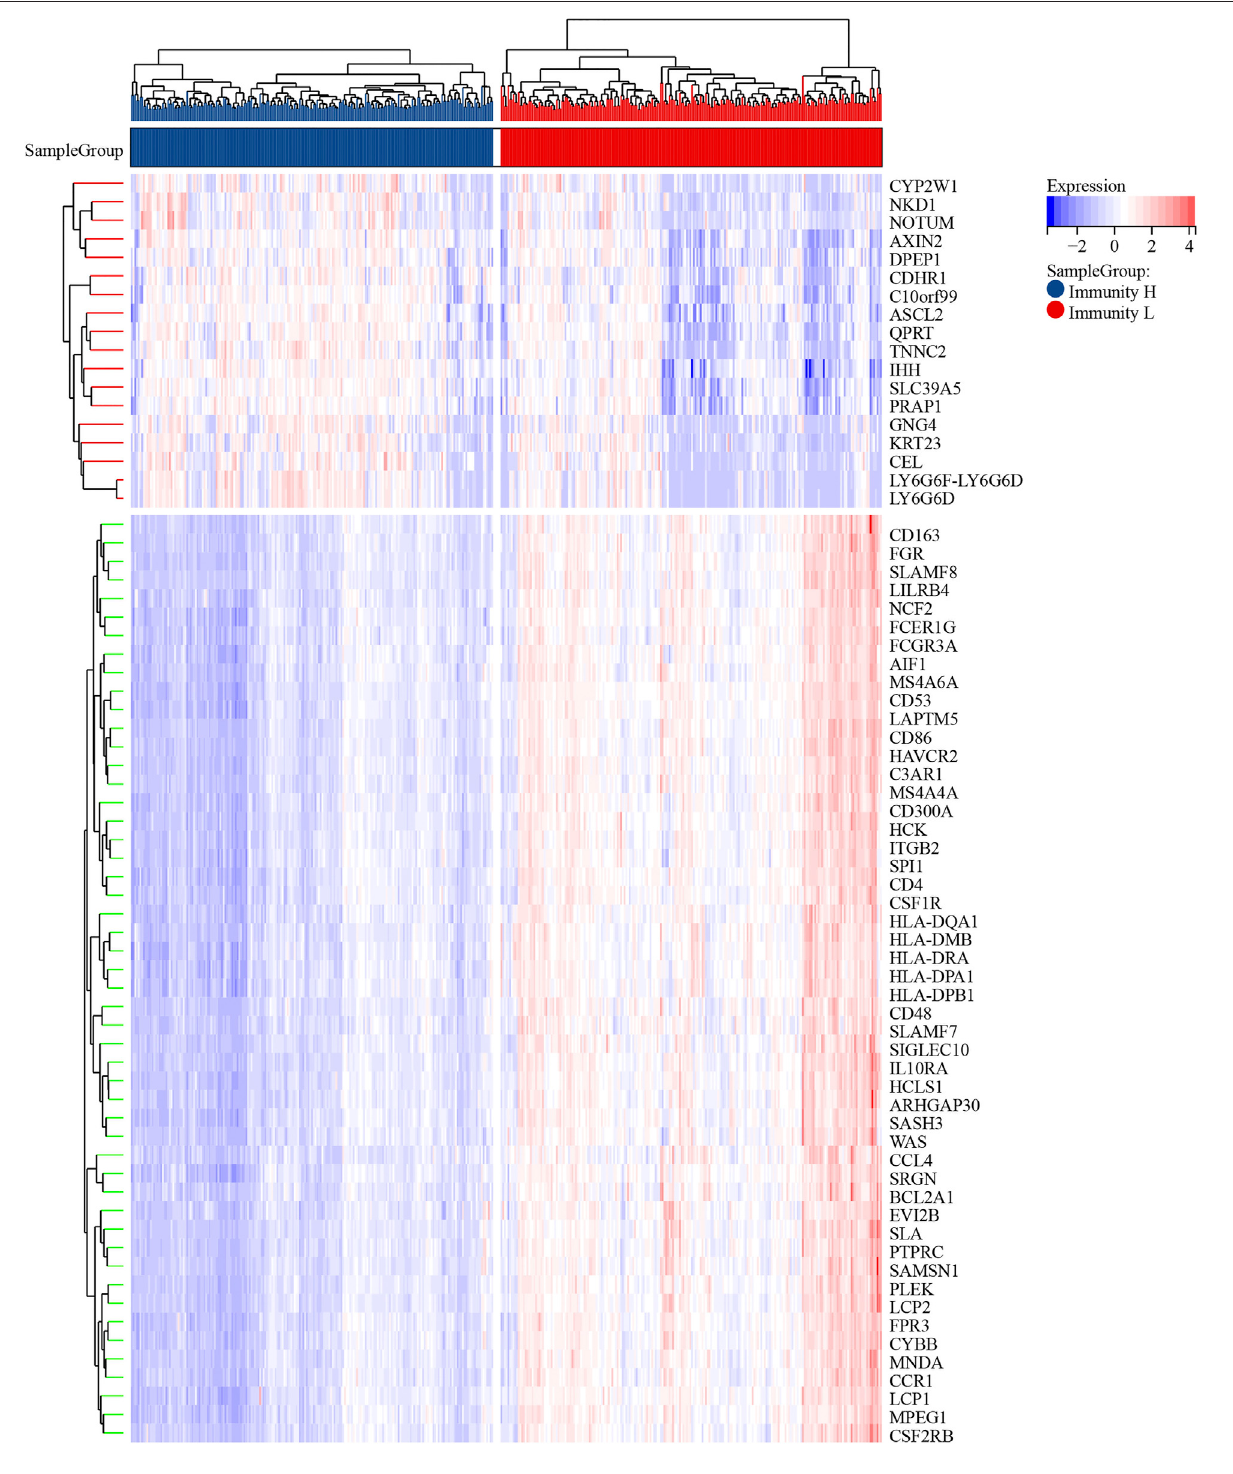
FIGURE 5 | The heatmap of differentially expressed genes.